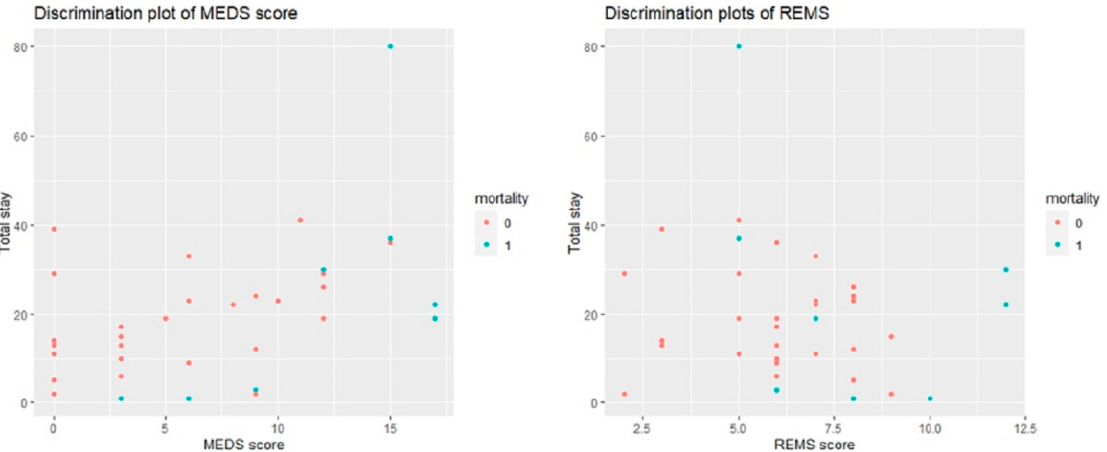
Figure 4. The MEDS was more than 12, and the mortality case numbers were 5, with a mortality rate of 14.3%. The REMS was more than 10, and the mortality case numbers were 3, with a mortality rate of 8.6%.